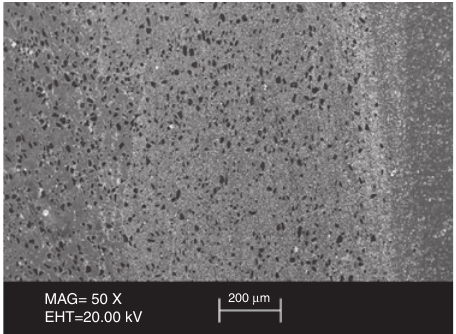
Figure 6 SEM microstructure image of the N1 sample.